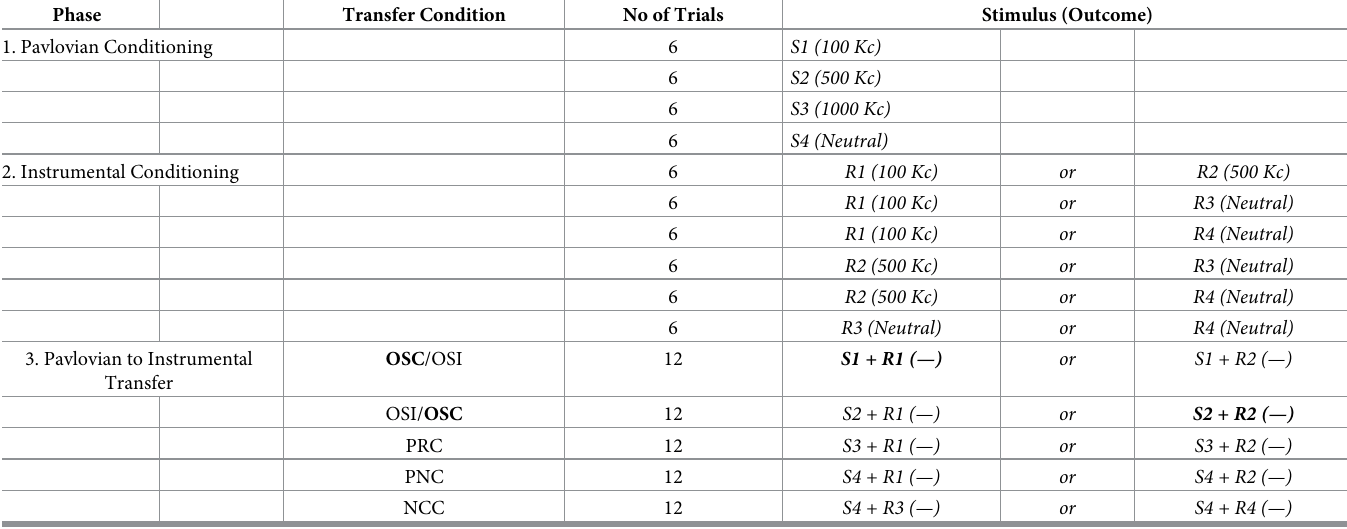
Table 2. Trial composition during conditioning and transfer phases of the Pavlovian-to instrumental transfer task. Phase Transfer Condition No of